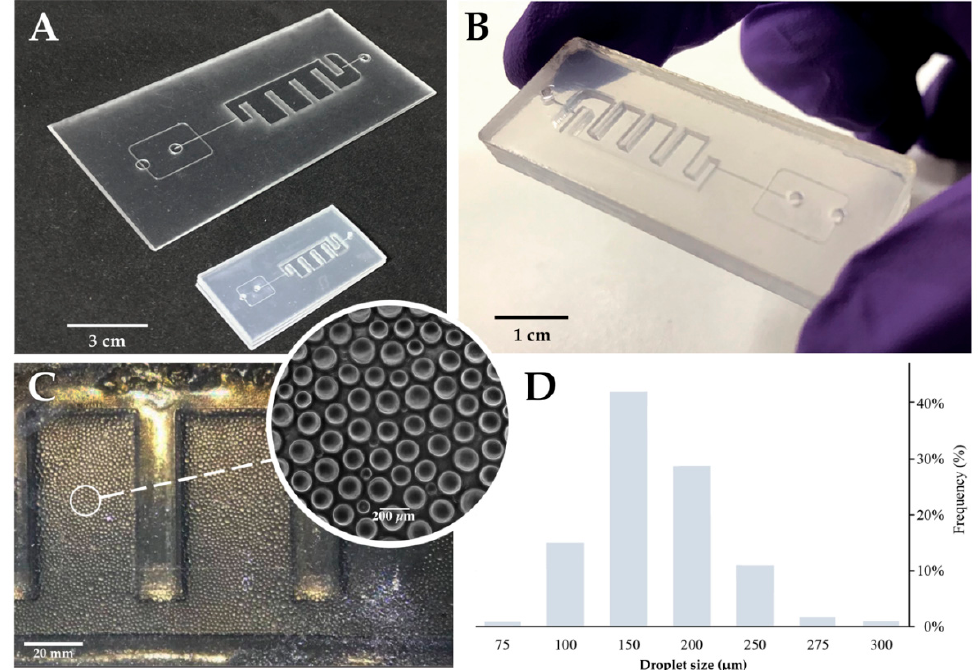
Figure 2. Multilayer Chip production and performance. ( A ) Multilayer chip before and after the shrinking process; the shrink was isotopically in plane and reduced around 66% of the original size. Additionally, this occurred in an increase in the height over 500%. Scale bar represents 3 cm. ( B ) Final chip appearance after frame removal. This step also helps seal the edges. Scale bar represents 1 cm. ( C ) On-chip droplets. Scale bar represents 20 mm; (inset) bright-field microscope image of the produced droplets inside the incubation chamber Scale bar represents 200 µm. ( D ) Frequency distribution of the droplet sizes. Droplets present a weighted average size of 170 µm, a coefficient of variation equal to 3% and a standard error of mean (SEM) of 0.27. Plot of the droplet size distribution for all the experiments (n = 6000 droplets). The mean volume of each droplets is ~2.6 nL.